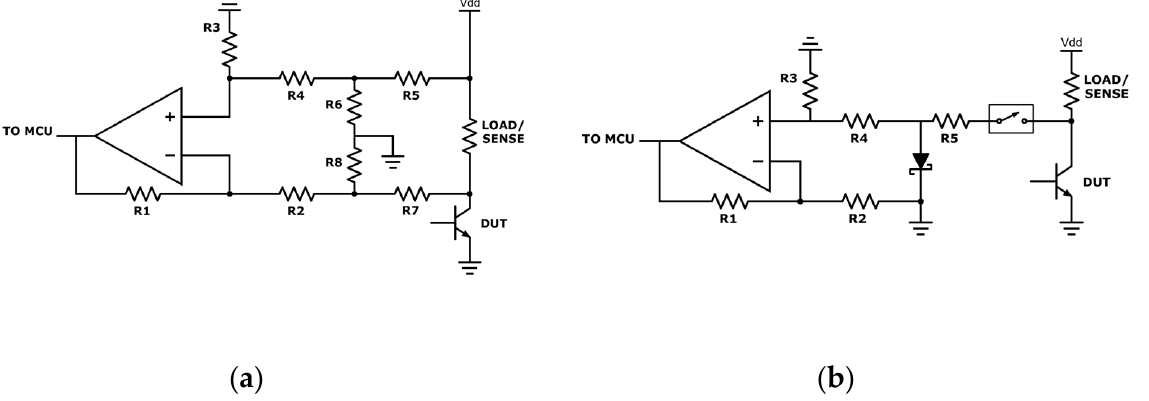
Figure 5. Drain sensing circuits: ( a ) drain current sensing circuit; ( b ) drain voltage sensing circuit.